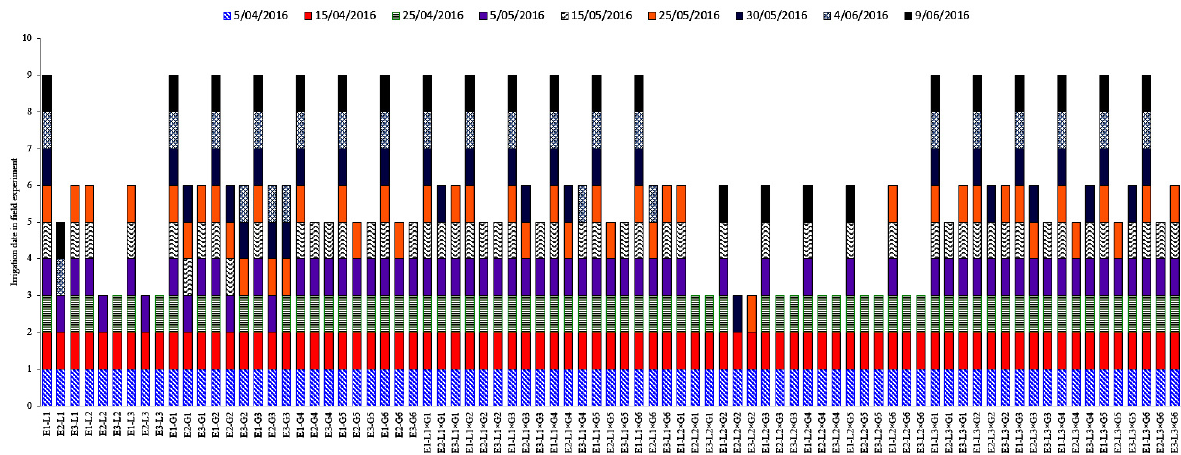
Figure 3. Irrigation times of genotypes in field experiments, e.g., E 1 L 1 , E 2 L 1 , and E 3 L 1 show the irrigation period of tester 1 under control (C), moderate water deficit (MWD), and severe water deficit (SWD) conditions, respectively.